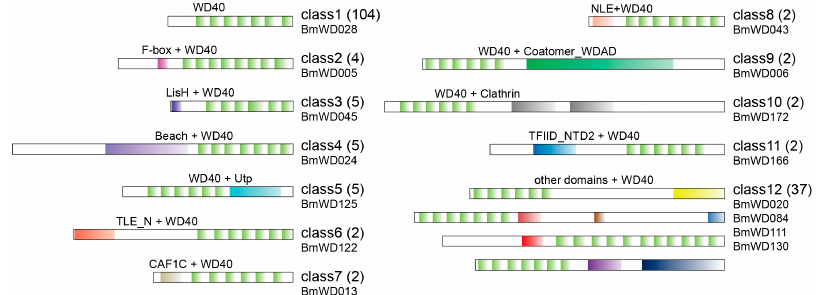
Figure 4. Domain architectures of Bm WD40 proteins. The protein structure is identified by WDSP, SMART and CDD. This organizes the Bm WD40s into 12 classes. The WD40 repeats are colored in light green, and other domains are filled in with other colors separately. The number of members in each class is shown in parentheses. The name of the displayed protein is given below.